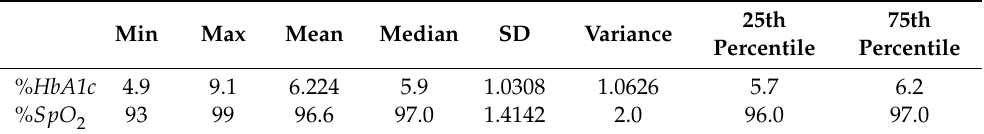
Figure 2. Histograms of the measured dataset: ( a ) %NGSP HbA1c and ( b ) % SpO (cid:2870) values. Table 3. Statistics of the measured %HbA1c and % SpO (cid:2870) data.